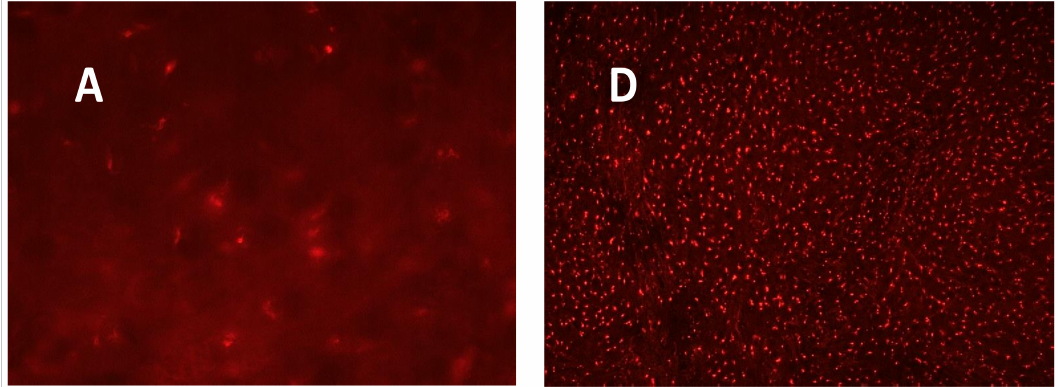
Figure 1. Case 2, meningioma with sclerosis areas. ( A ): PKA RII immunofluorescence. ( B ) Same photographic field, nuclei are labelled with DAPI. ( C ) Merge of ( A ) and ( B ). ( D ) Negative control, omission of primary antibody in an adjacent section (incubation with only secondary antibody, red-labelled) results in no red signals. Unaltered images. A and D taken with the same filters setting and same exposure time from adjacent sections. Objective: 40x. Bar = 25 µ